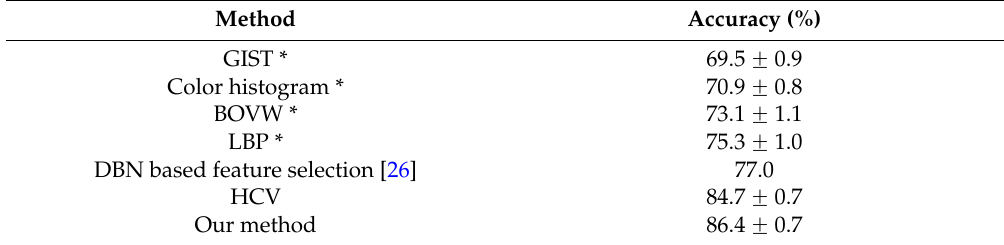
Table 4. Comparison of our approach (FV + HCV) with the state-of-the-art performance reported in the literature on the RSSCN7 database under the same experimental setup: half of images from each class are used for training and the rest are used for testing. The average classification accuracy (mean ˘ SD) is set as the evaluation index. DBN: Deep Belief